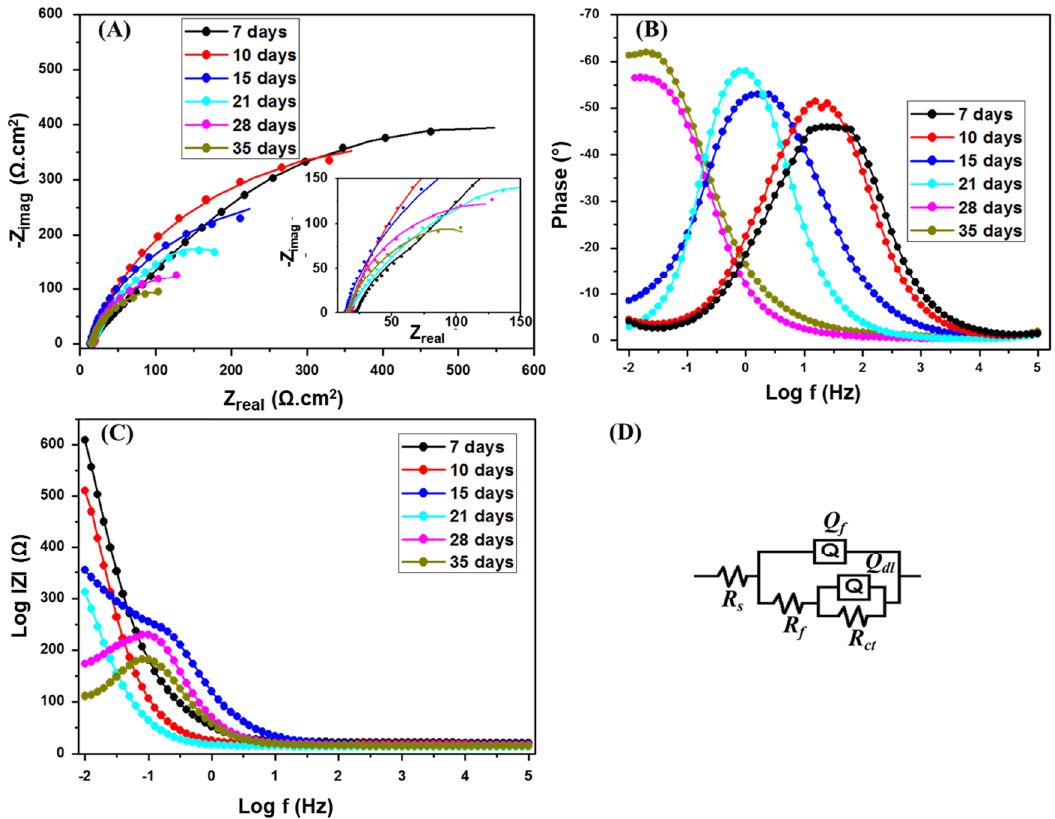
Figure 3. Nyquist ( A ); Bode ( B , C ) plots of SRB with CS / LS. The inset is a zoom of the low impedance region. The EIS were recorded at a range of 0.01–10 5 Hz. ( D ) Equivalent circuit used for fitting. From the phase angle θ vs. frequency, in the logarithmic scale plot (Figure 3B), the phase peak has shifted to a lower frequency with increasing incubation time similar to the SRB corrosion